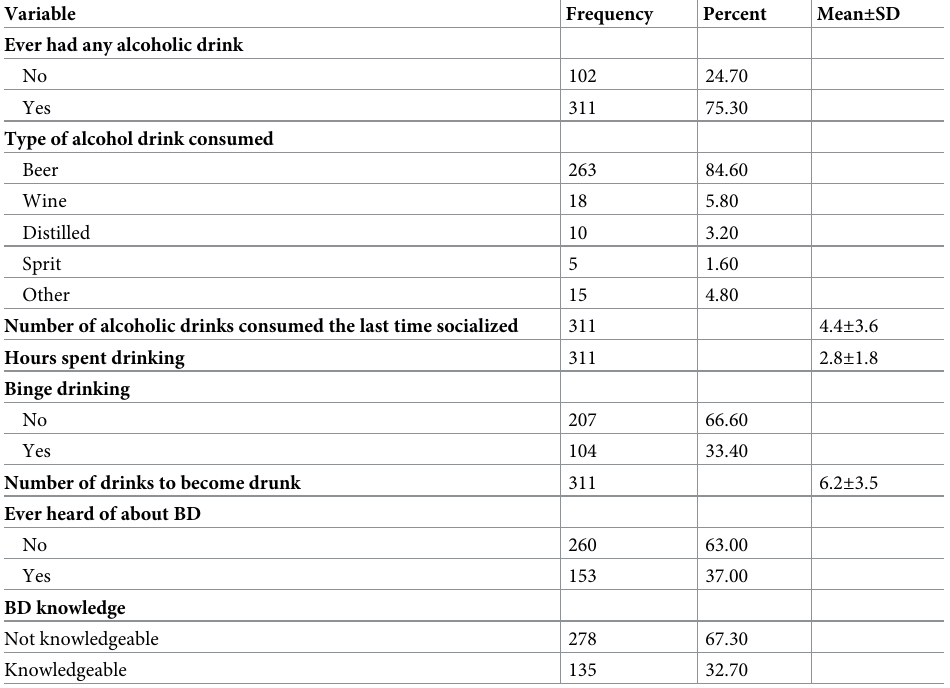
Table 2. Alcohol drinking pattern, binge drinking and knowledge of participants (n =